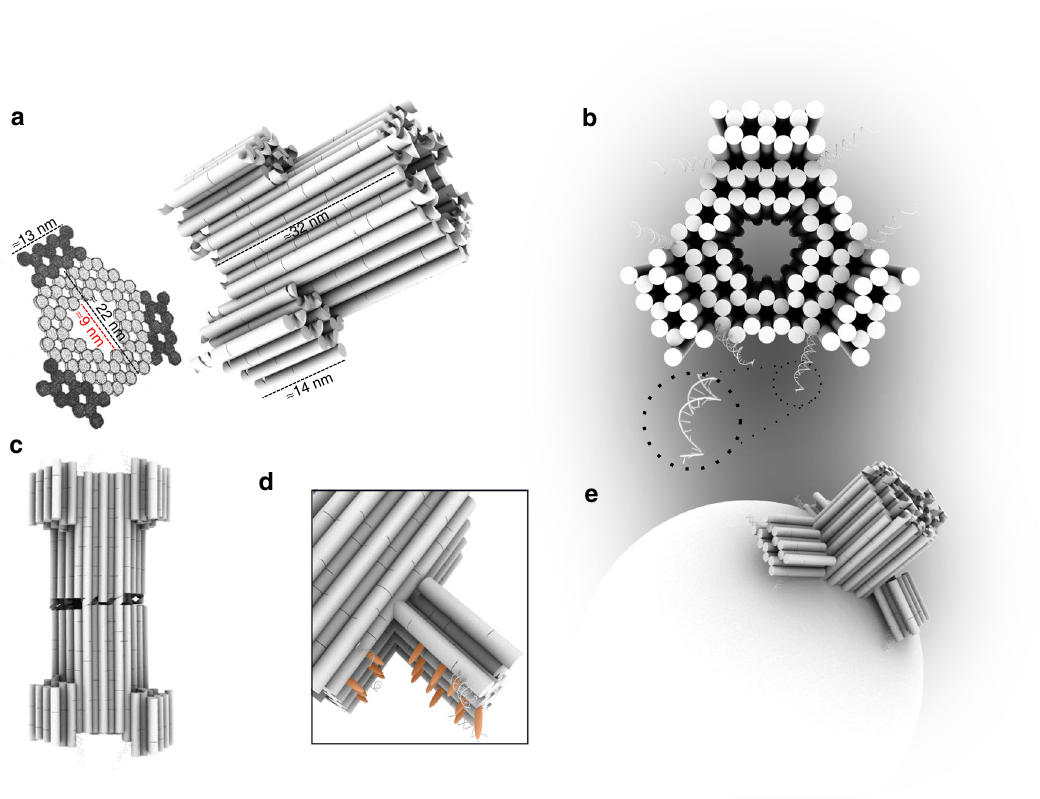
Fig. 1 Design of the DNA nanopore. a The pseudosymmetric nanopore is based on a hexagonal origami lattice and has a 9-nm inner pore diameter, a 22-nm outer diameter, and a length of 32 nm. b The three fl aps are each locked with two dsDNA hybrids that possess an 8-nt toehold for strand displacement opening. c At the top, 27 staple strands are extended with unique 8-nt sequences to allow speci fi c sticky end-mediated dimerization upon mixing A and B nanopores. d Lipidated nucleic acid staples (orange protrusions) are displayed at the surface of the channel and the fl aps when opened. e Schematic illustration of the nanopore inserted into a liposome.